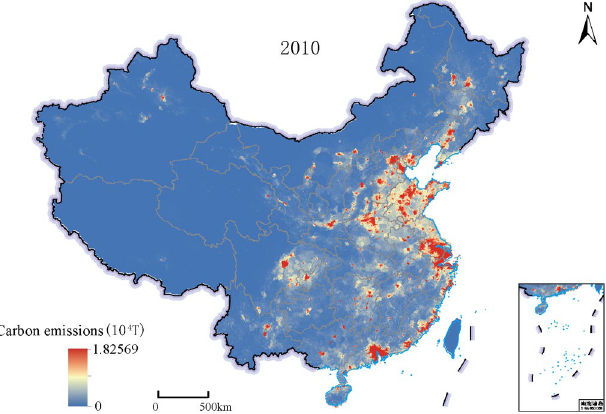
Figure 1. Results of 1 km spatialization of Carbon Emissions in China in 2010 based on the SVR model. This map is based on the standard map No. GS(2019) 1823 downloaded from the Ministry of Natural Resources Standard Map Service website. The base map is unchanged.